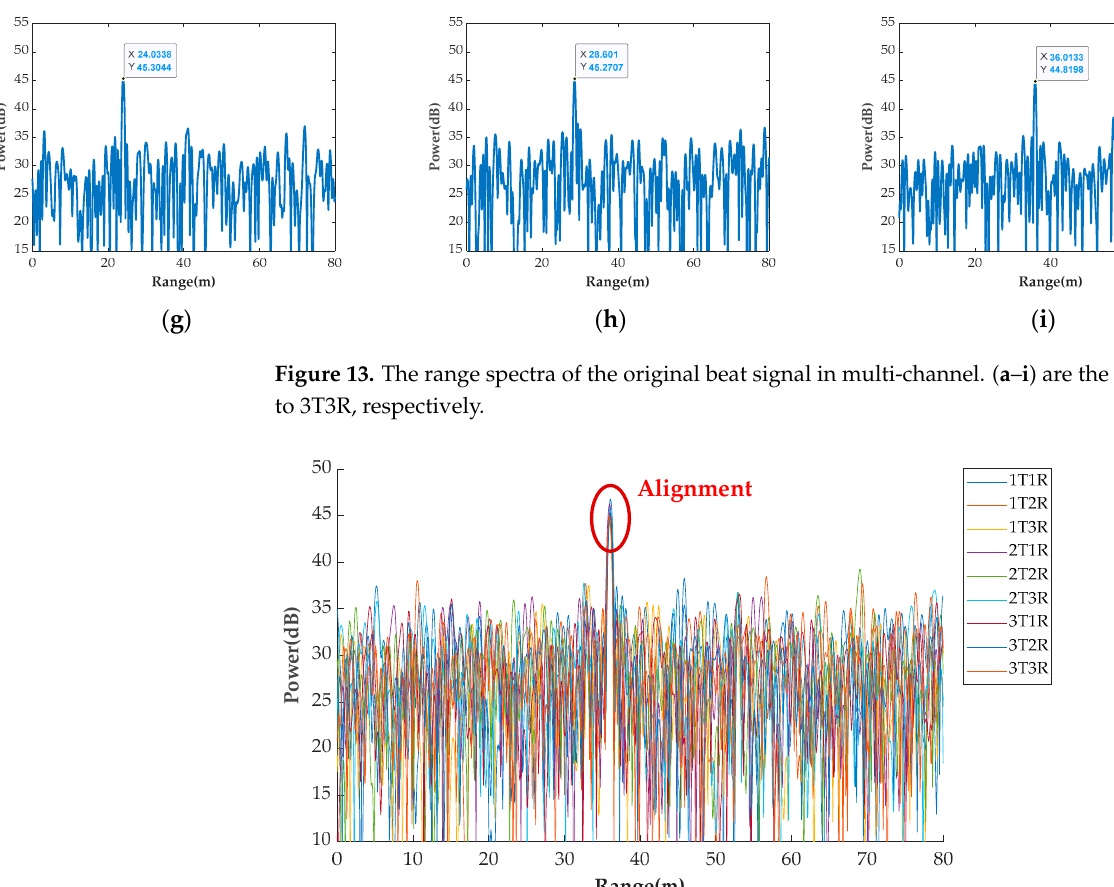
Figure 14. The range spectra after dominant scatterer compensation.